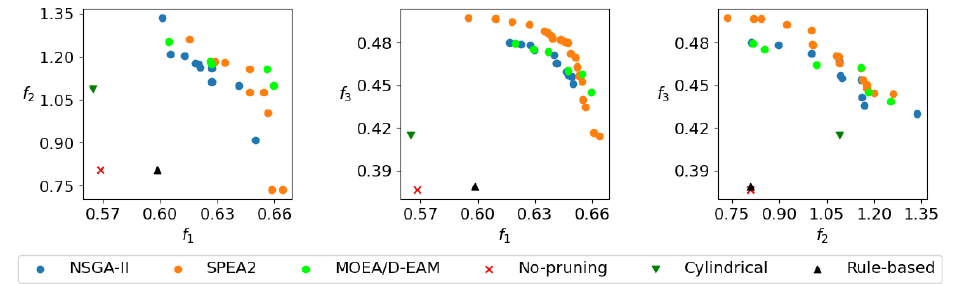
Figure 9. Two-dimensional projections of non-dominated sets for the tree from Figure 6a.